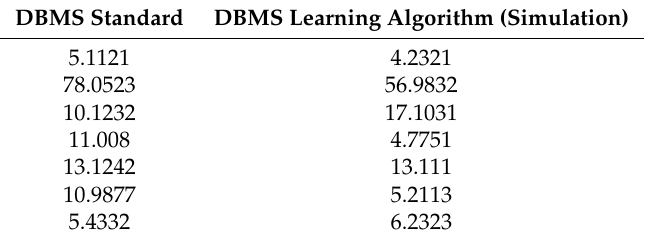
Table 4. Comparative costs at different intervals of reads